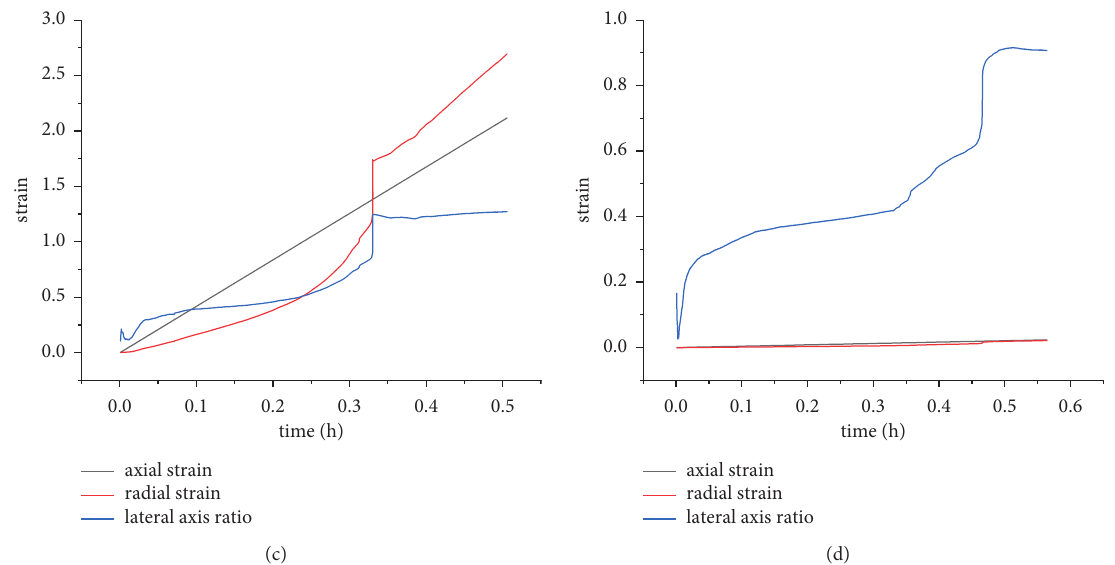
Figure 6: Time-strain characteristic diagrams of coal sample. Time-strain characteristic diagram under (a) 0 MPa confining pressure, (b) 3 MPa confining pressure, (c) 5 MPa confining pressure, and (d) 7 MPa confining pressure.